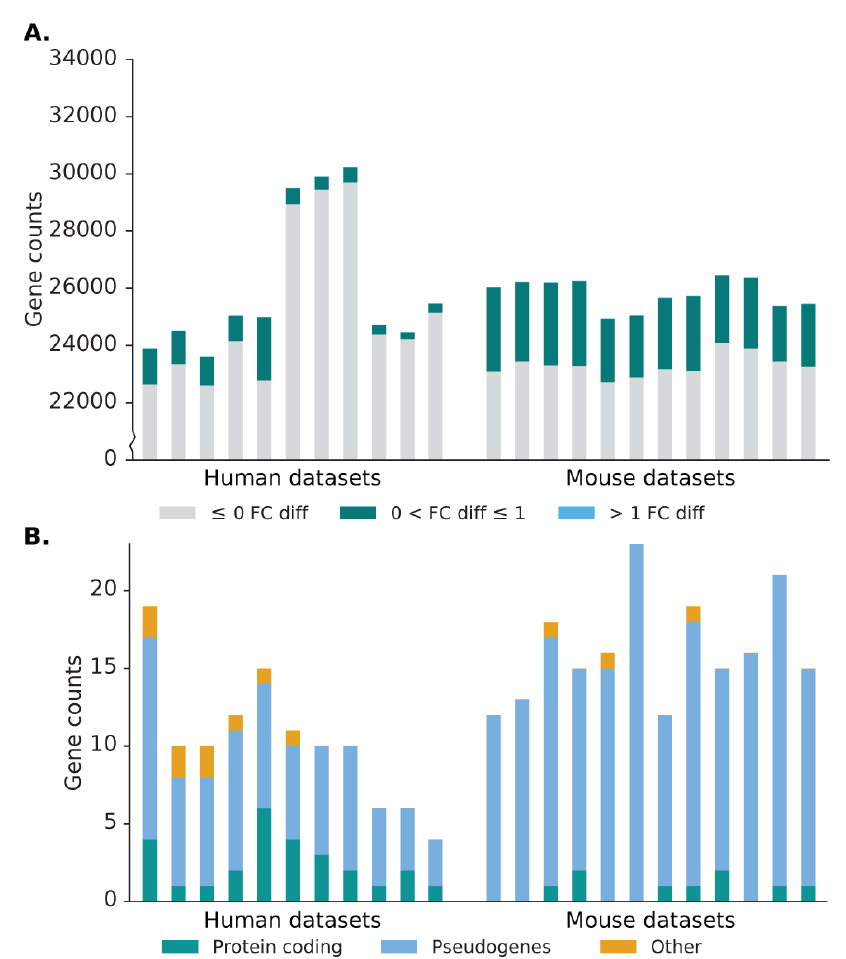
Figure 5. Effect of Scavenger read recovery on gene expression for normal (bulk) RNA-seq datasets. A . The number of genes whose reads are recovered by Scavenger, categorised based on the fold change in normalised expression (RPM) between source alignment and after Scavenger recovery. B . The number of genes with more than 1 fold change in normalised expression categorised based on their gene